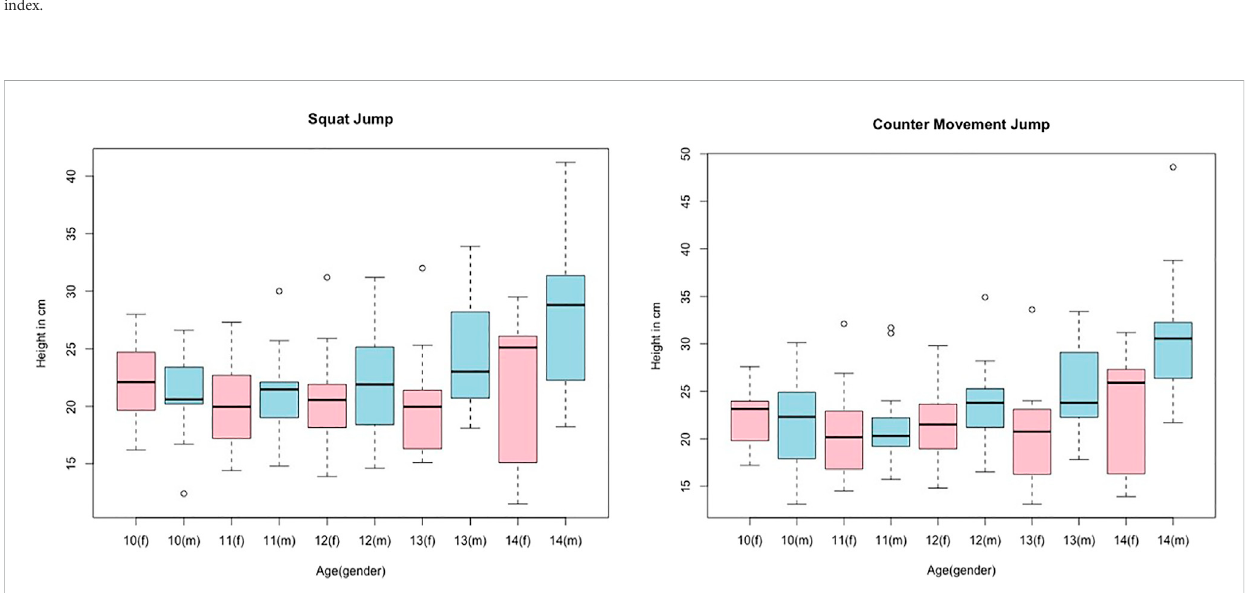
FIGURE 2 Box plots for jump height in SJ and CMJ dependent on age and sex; blue color represents males, and pink color represents